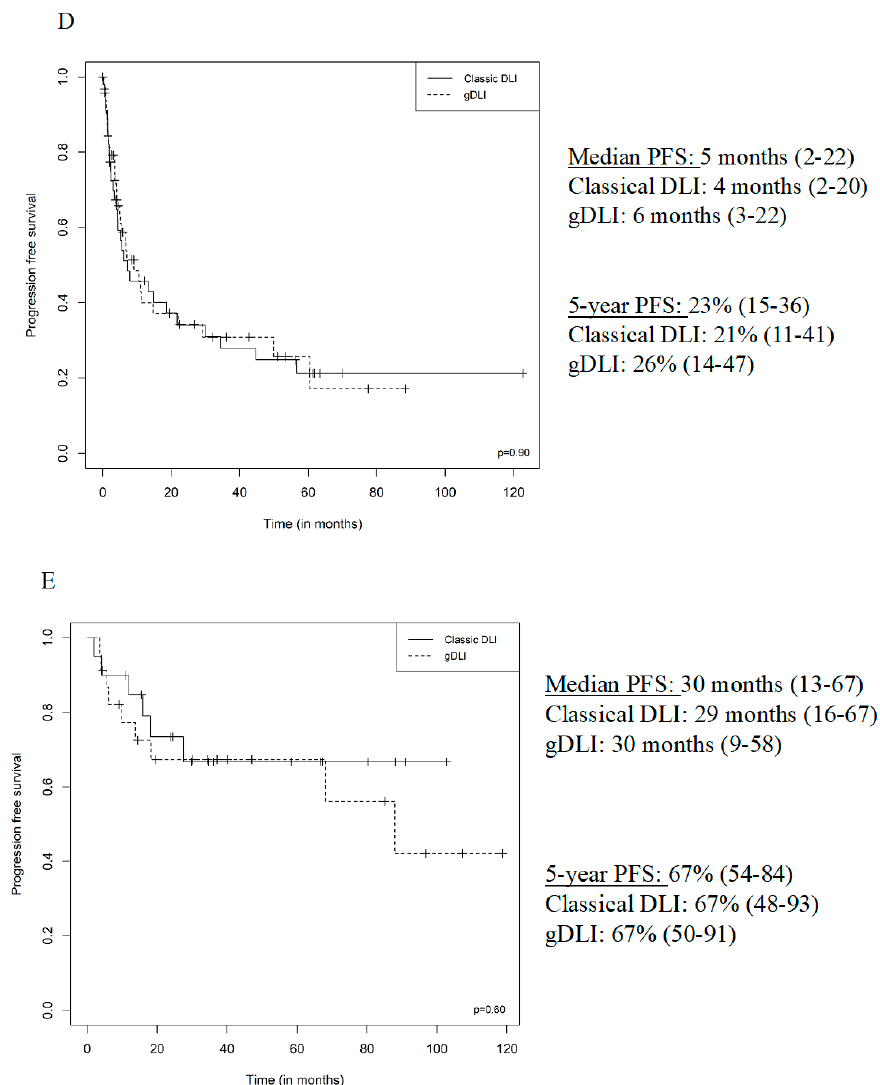
Figure 2. PFS from first DLI according to DLI type (Classical, gDLI), ( A ) all patients, ( B ) multiple myeloma, ( C ) acute myeloid leukaemia, ( D ) relapse indication, ( E ) pre-emptive indication.